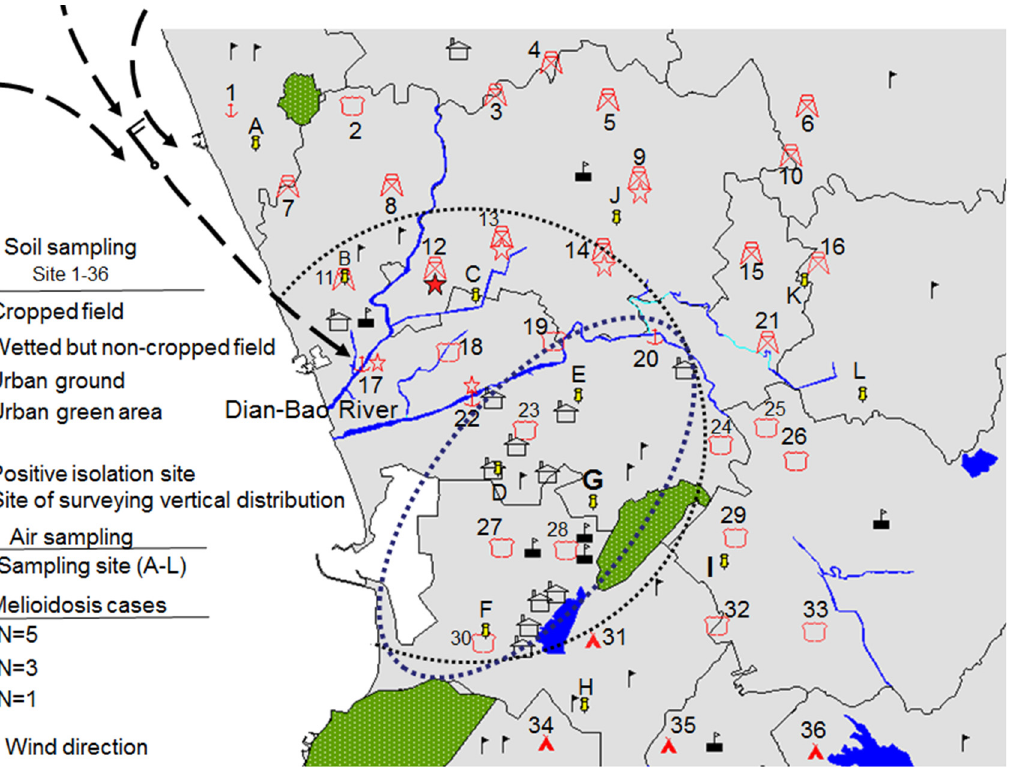
Fig 1. The distribution of melioidosis cases and sampling sites. Using a random sampling strategy, the locations of sampling sites of the cropped field, wetted but non-cropped field, urban ground or urban green area are shown (legends on left of the figure). The positive isolation sites of the sampling sites are labeled with hollow or solid red stars. The solid red star indicates a site that was sampled using the fixed-interval strategy. The melioidosis locations are indicated by different symbols representing the number of melioidosis cases (see left on the figure). The circle on the map indicates the endemic areas of melioidosis (n = 75, defined in a previous study [21]). An ellipse on the map indicates the core region of melioidosis cases (n = 68, defined by this study). The hypothesis is that aerosols contaminated with B . pseudomallei are carried by wind (wind direction indicated by dotted lined with a directional arrow) from the northwestern contaminated cropped field (red star) and envelop the endemic area, particularly the core region, during the rainy (typhoon) season.